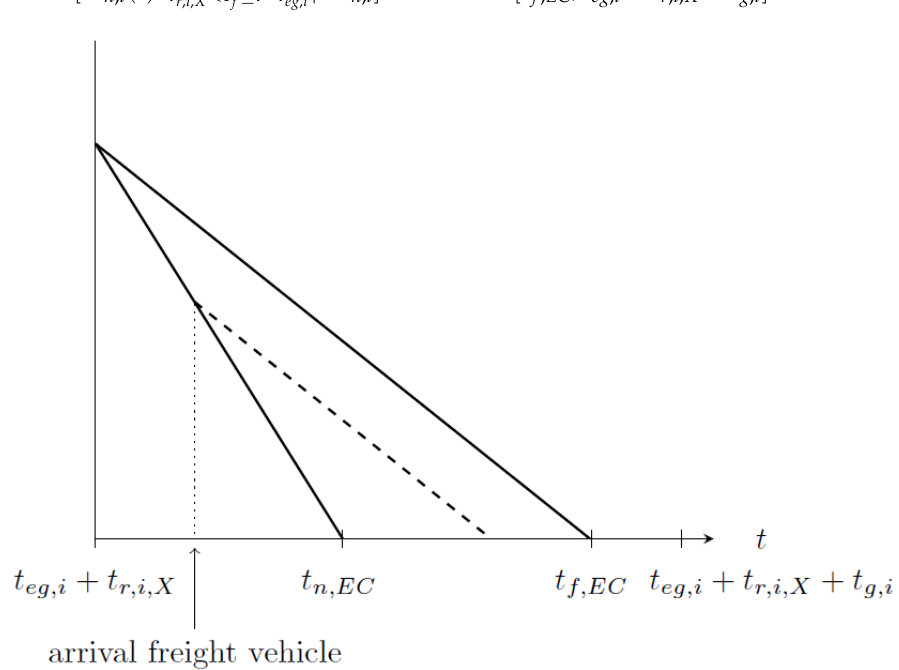
Figure 2. Examples of different scenarios for the dissolution of the queue during the green time of an extended cycle when no freight vehicle has arrived in the corresponding red